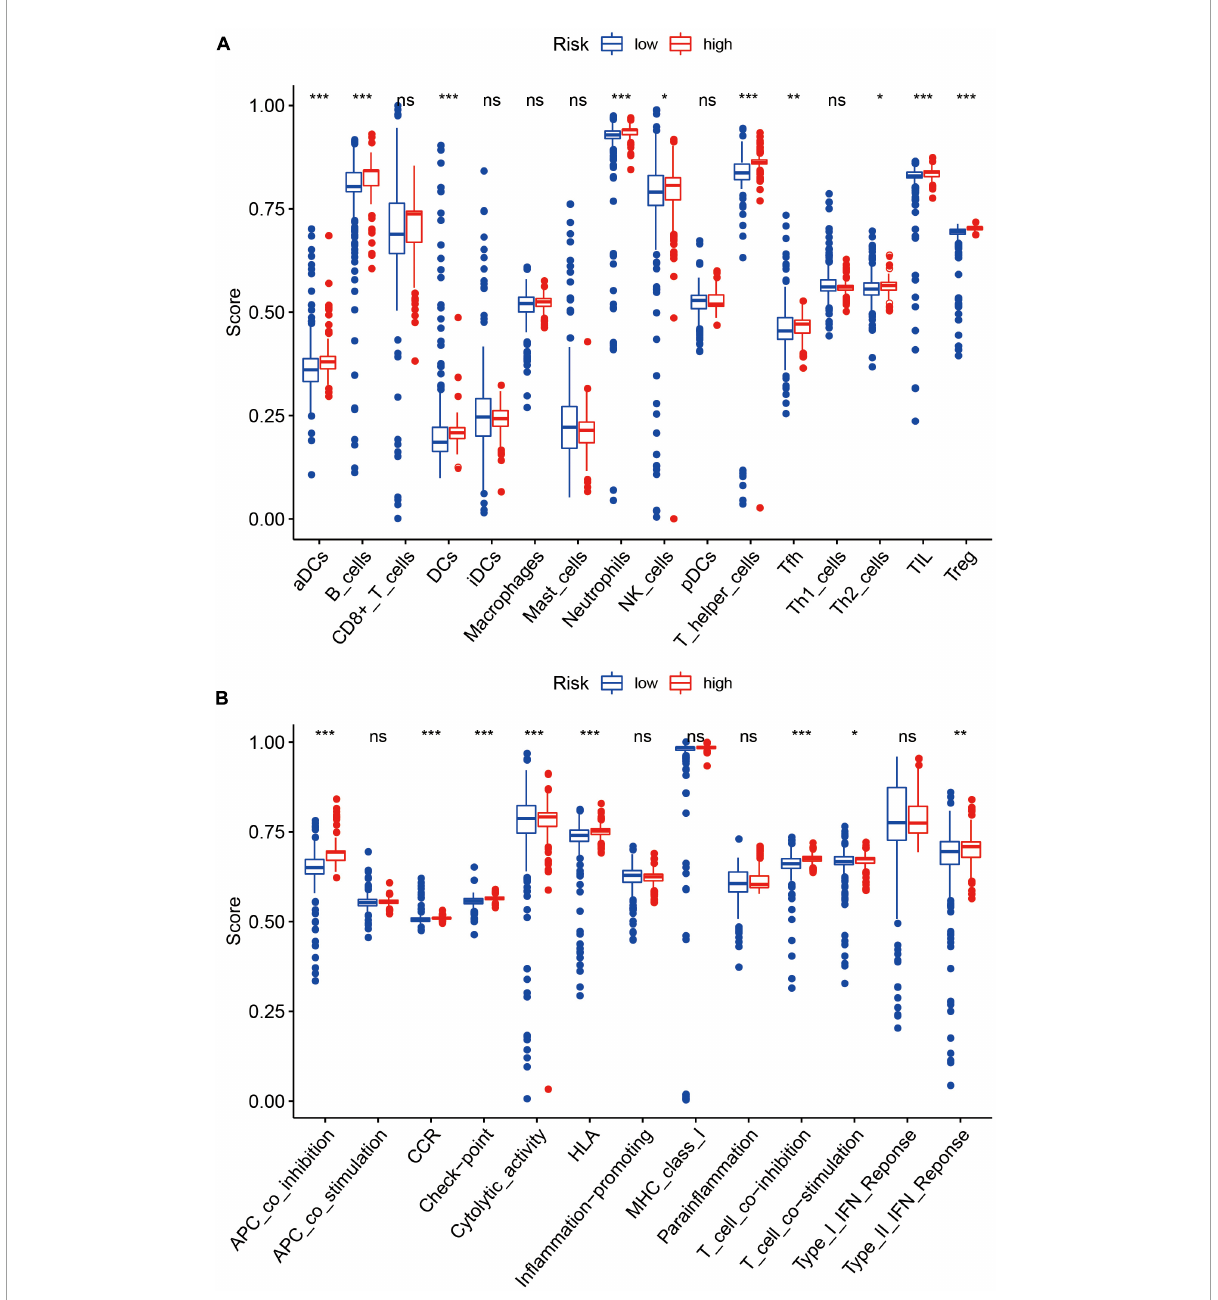
FIGURE12 (A) Elements related to antigen presentation process contents such as aDCs, B cells, and DCs were significantly up-regulated in the high-risk group (all P < 0.05). Elements related to cellular immunity, such as neutrophils, NK cells, T helper cells, Tfh, Th2 Cells, TIL, and Tregs, were also up-regulated in the high-risk group. * P < 0.05; ** P < 0.01; *** P < 0.001. (B) The contents of the antigen presentation process, including APC co-inhibition, CCR, Check-point, Cytolytic activity, HLA, T cell co-inhibition, T cell co-stimulation, and Type II IFN Response were significantly up-regulated in the high-risk group. * P < 0.05; ** P < 0.01; *** P < 0.001.